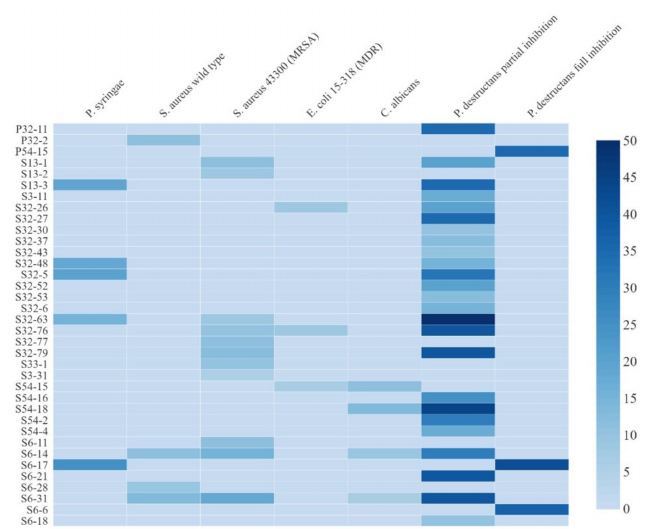
Figure 4. Heat map representing antimicrobial activity of actinobacteria from mosses against two drug-resistant bacteria and two fungal pathogens. The legend on the right size indicates the diameter of the zone of inhibition (in